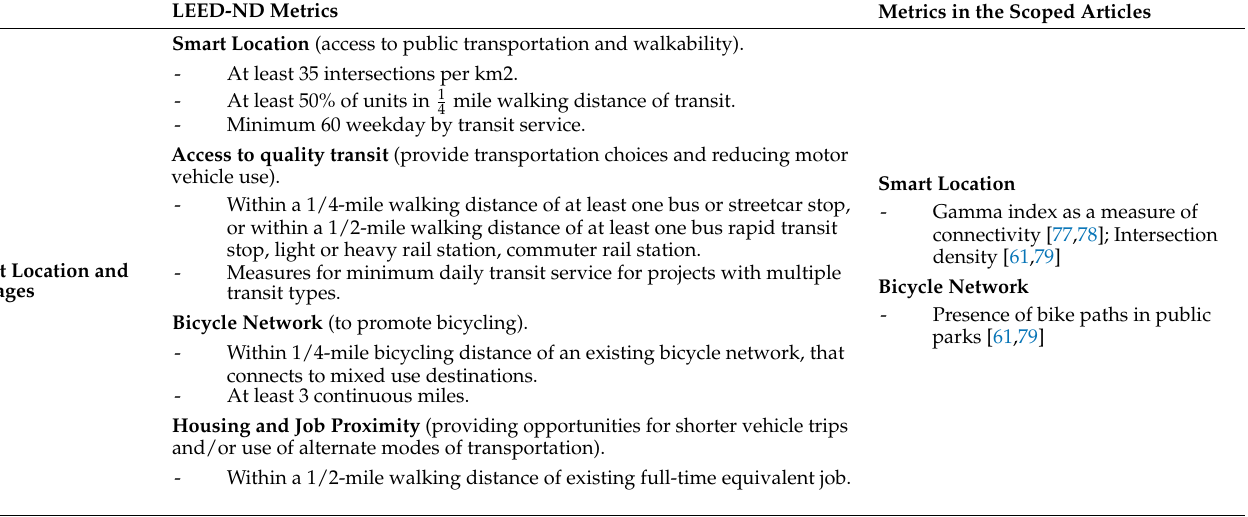
SLL Smart Location and